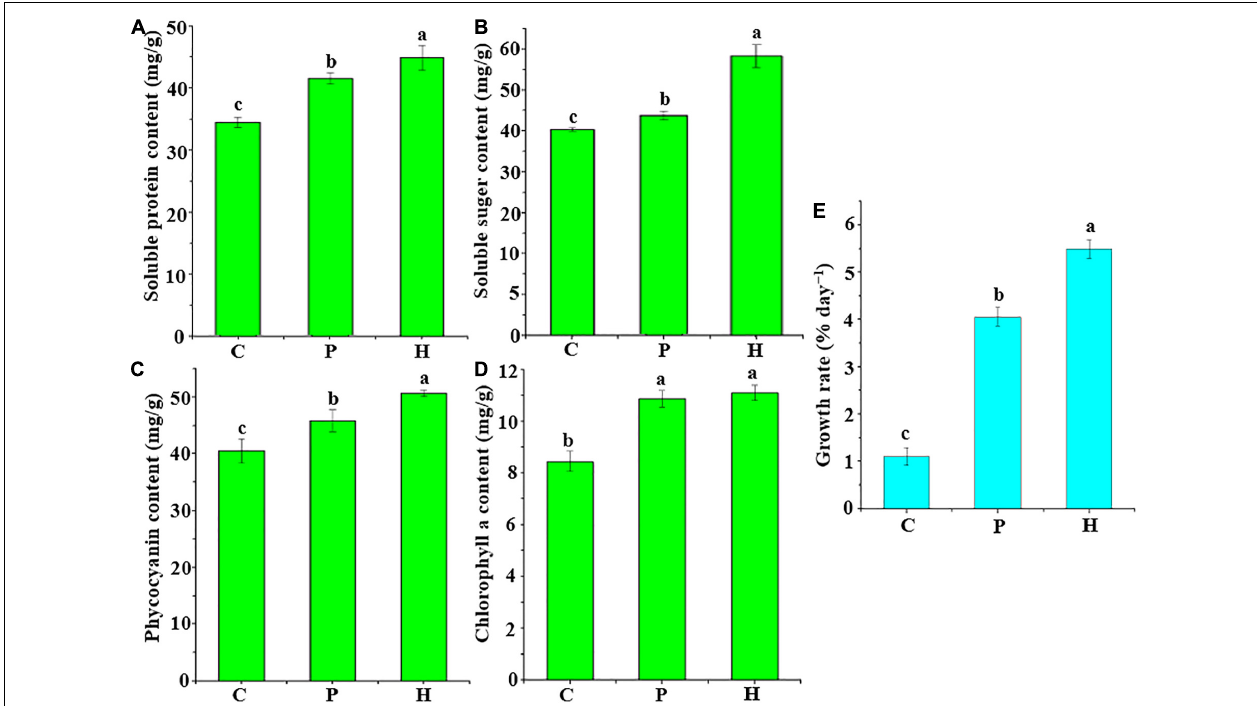
FIGURE 3 | Changes of growth rate and four physiological indices of bacterial treatment and U. fasciata (WSB). (A) Soluble protein content, (B) Soluble sugar content, (C) Phycocyanin content, (D) Chlorophyll a content, and (E) Growth rate. C group used sterile seawater for the negative control, P group only contains Bacillus cereus U5-30 strain was used to be the positive control, H group contained only one strain of Hyunsoonleella sp. HU1-3, the difference coefficient represents the difference between C, P, and H